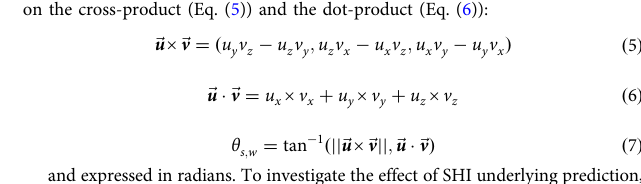
in the 3-D k 0 -space, spanning from the point of origin to the coordinates determined by the k 0 -values in the x s ; w (150ms), y s ; w (300 ms), and z s ; w (600ms)